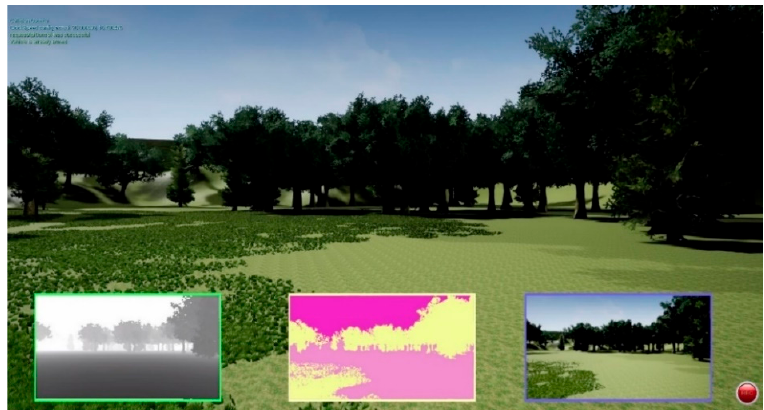
Figure 20. AirSim environment screenshot.